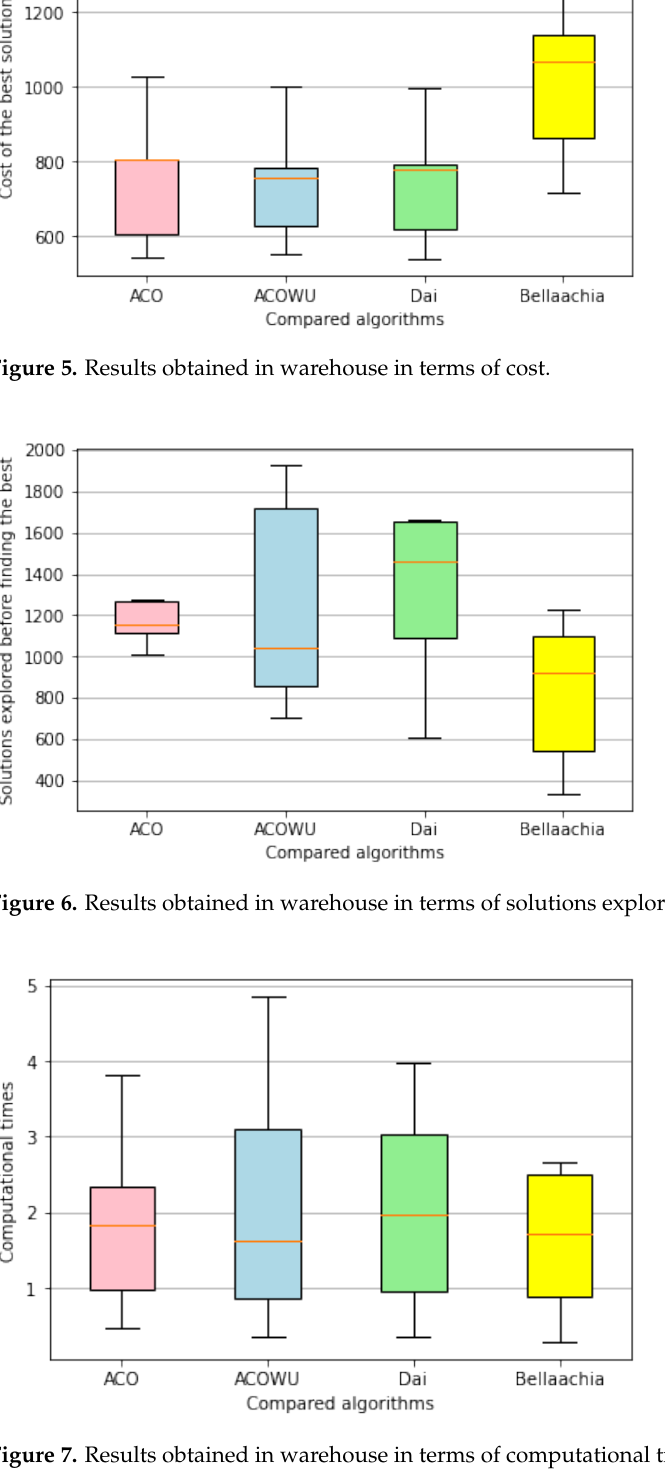
Figure 7. Results obtained in warehouse in terms of computational